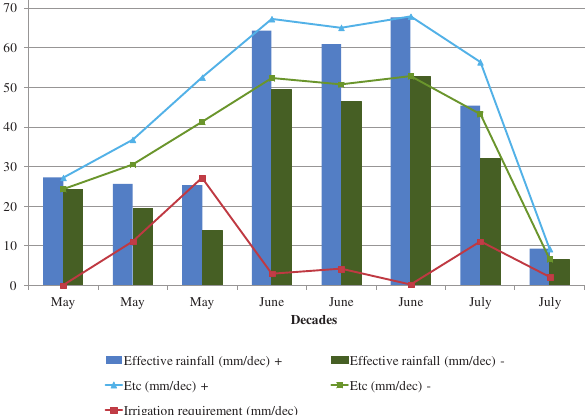
Figure 5. Irrigation requirement and evapotranspiration of Veinberger in 2003 (+: with active ground cover, –: bare